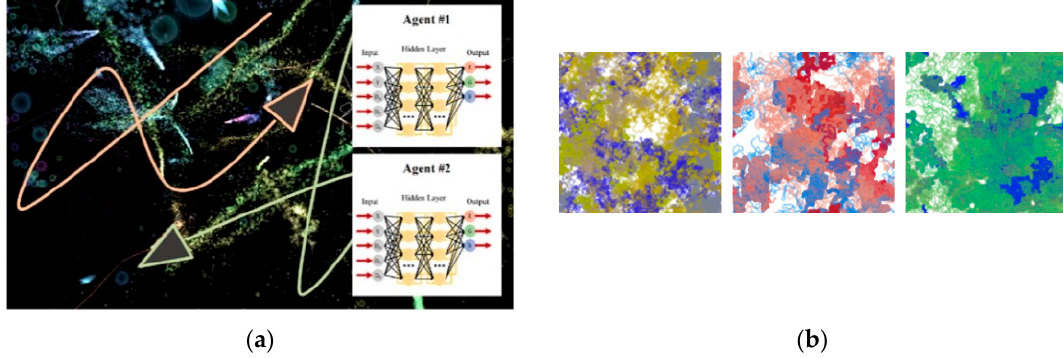
Figure 1. Sample outputs of agent-based evolutionary art. ( a ) An evolutionary artwork generated with Boids model and evolutionary chaotic neural network. ( b ) Evolutionary artworks generated by Greenfield’s ant painting method.